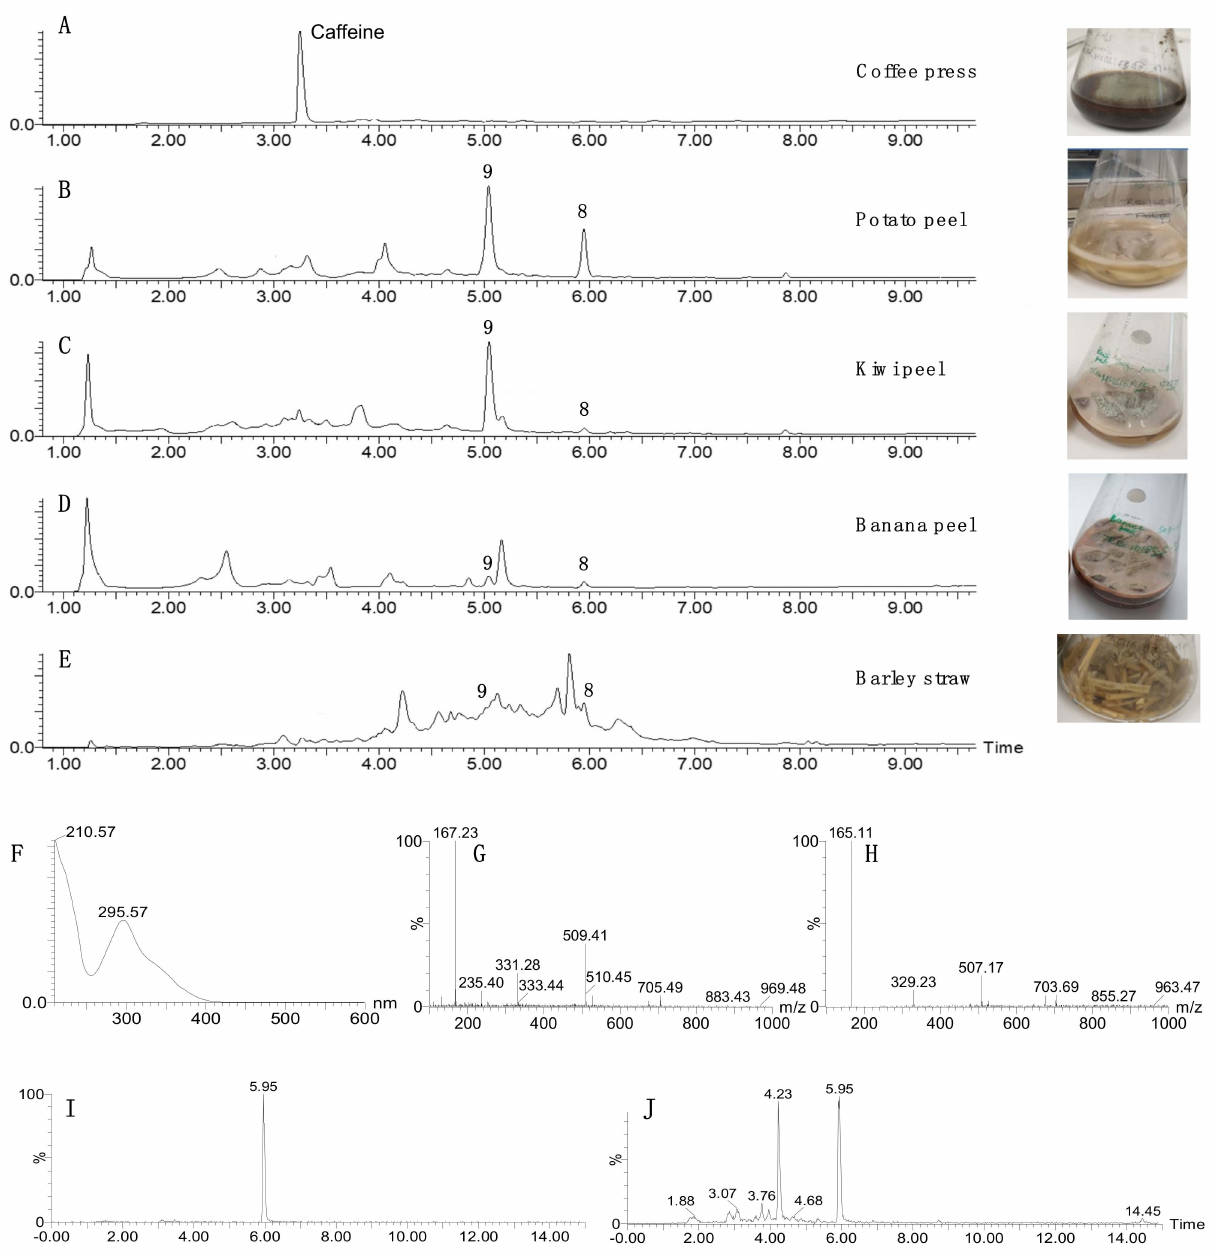
Figure 4. LC–MS traces of T. reesei QM6a · ∆ tmus53 · ∆ sorBC · P pdc · aspks1 cultivated on different media after 14 days of growth. ( A ), grown on coffee press; ( B ), grown on potato peel; ( C ), grown on kiwi peel; ( D ), grown on banana peel; ( E ), grown on barley straw; ( F ), uv diode array detector (DAD) trace of 5.95 min peak; ( G ), ES+ spectrum of 5.95 min peak; ( H ), ES- spectrum of 5.95 min peak; ( I ), extracted ion chromatogram (EIC, ES- 165) for barley straw fermentation; ( J ), EIC chromatogram (ES+ 167) for barley straw